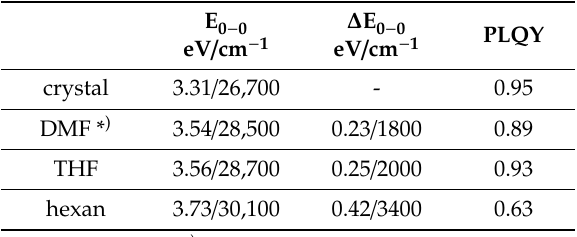
Figure 8. Normalized absorption and PL spectra of p-quinquephenyl in the solutions of hexane and THF. The calculated luminescence spectrum of the crystal without reabsorption I R = 0 ( λ ). Table 2. The position of 0 − 0 transition and the PL quantum yield of p-quinquephenyl in the crystal and diluted solutions.